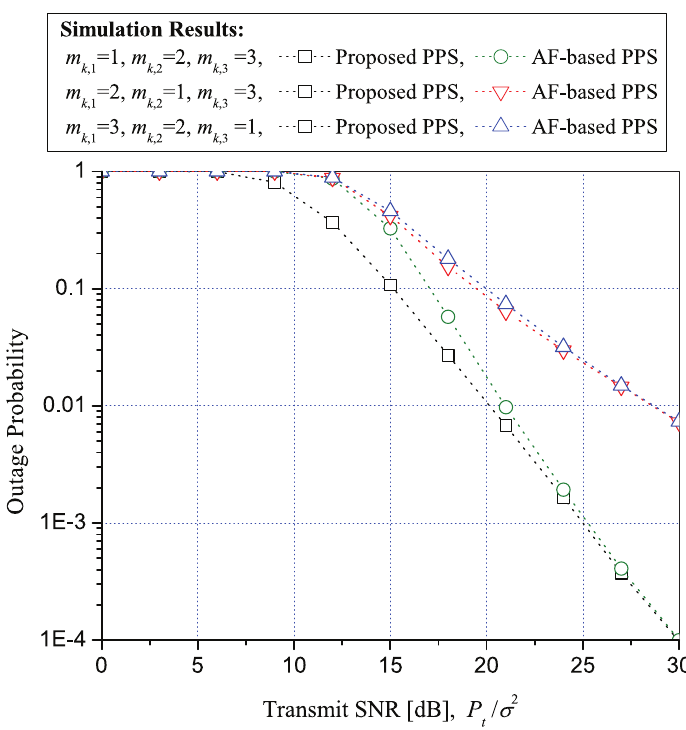
Figure 7. Outage probability of the proposed PPS with l k = 1 for all k and the conventional AF-based PPS, when m k , n ’s are unequal, N k = 3 for all k , K = 3, and R t = 1